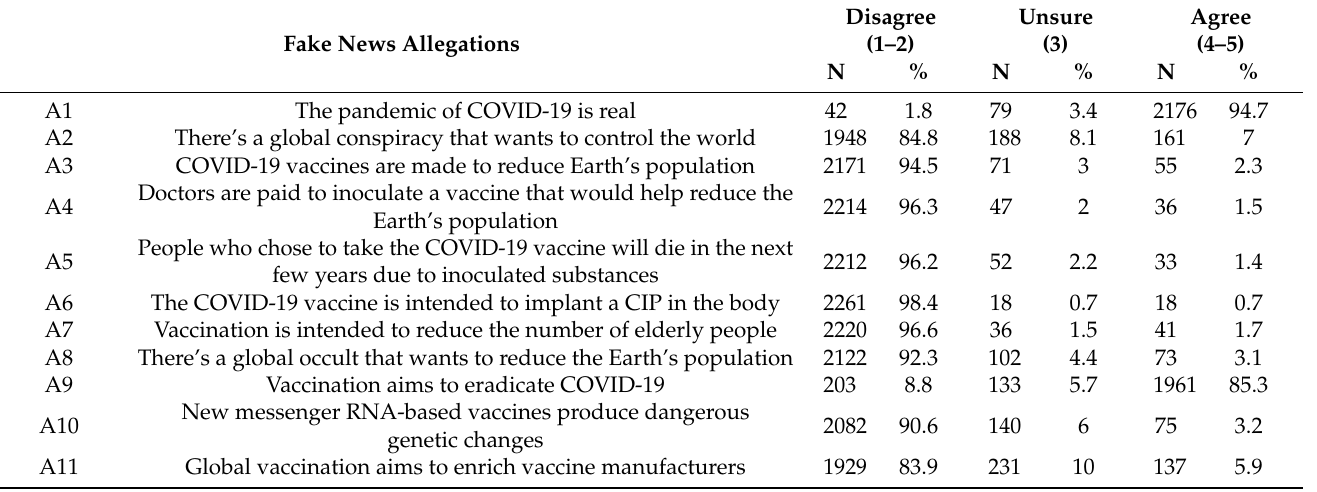
Table 8. Participants’ trust in “fake news”